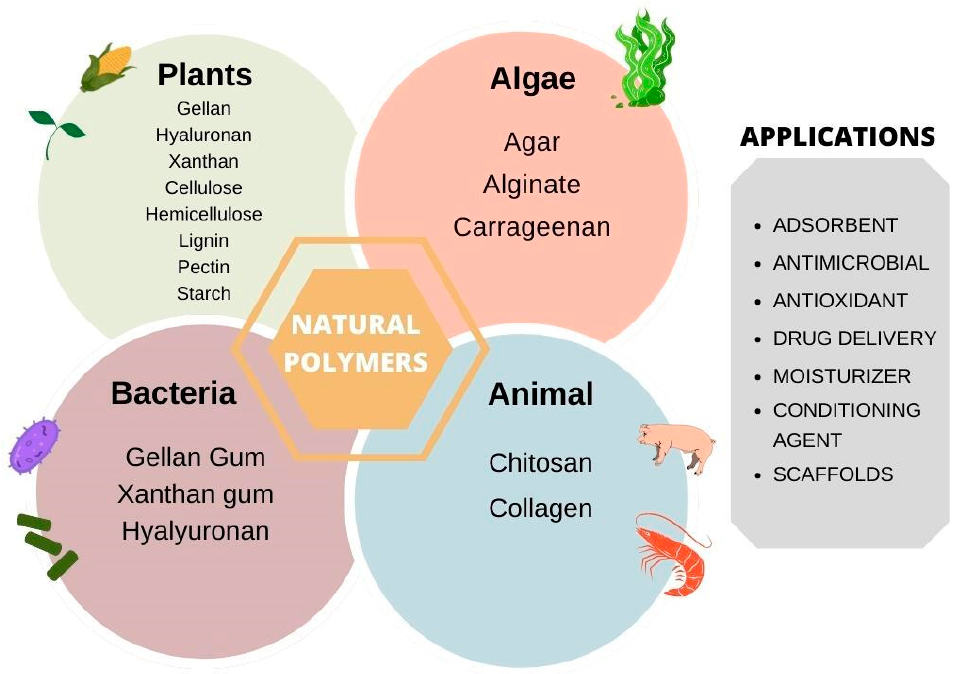
Figure 5. Bio-gels derived from natural sources and their functions.